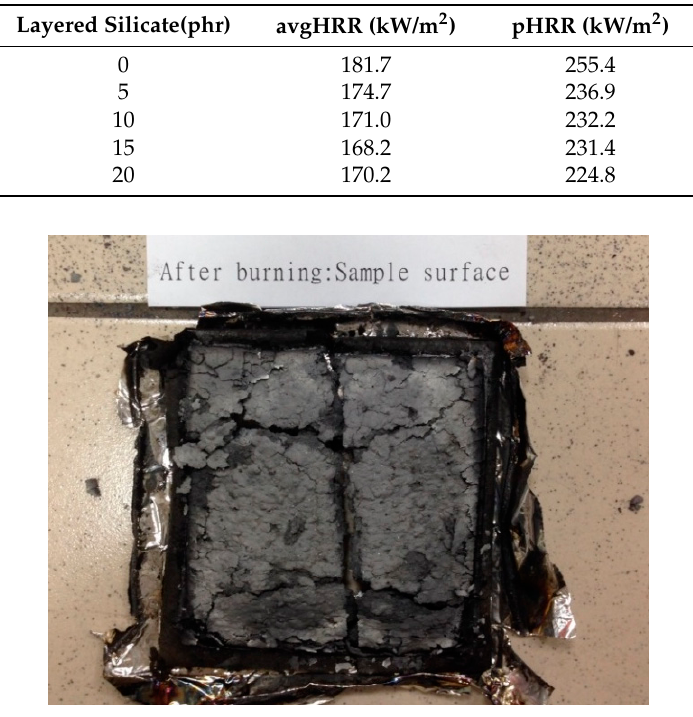
Figure 7. Photographic image showing char formation on an EPDM/CR nanorubber (10 phr layered silicates) after burning.